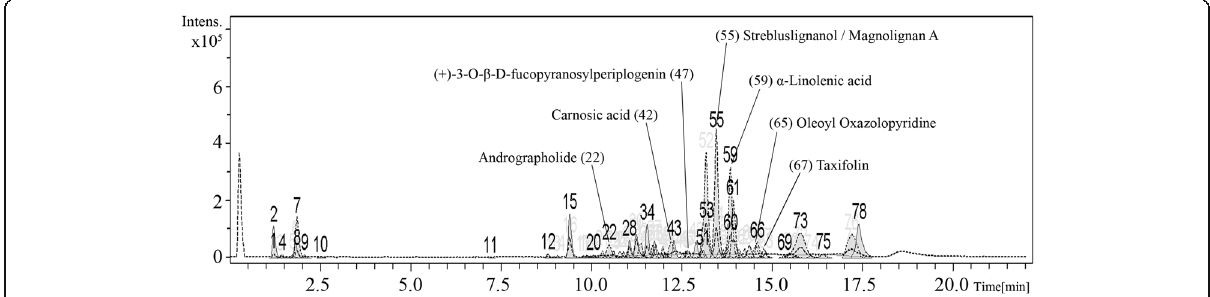
Fig. 7 LC-MS chromatogram of SA-EE. The total ion chromatogram (TIC) of SA-EE was analyzed using LC-MS under positive electrospray ionization. Peak numbers indicate the proposed compounds as follows: andrographolide (22), carnosic acid (42), (+)-3-O- β -D-fucopyranosylperiplogenin (47),